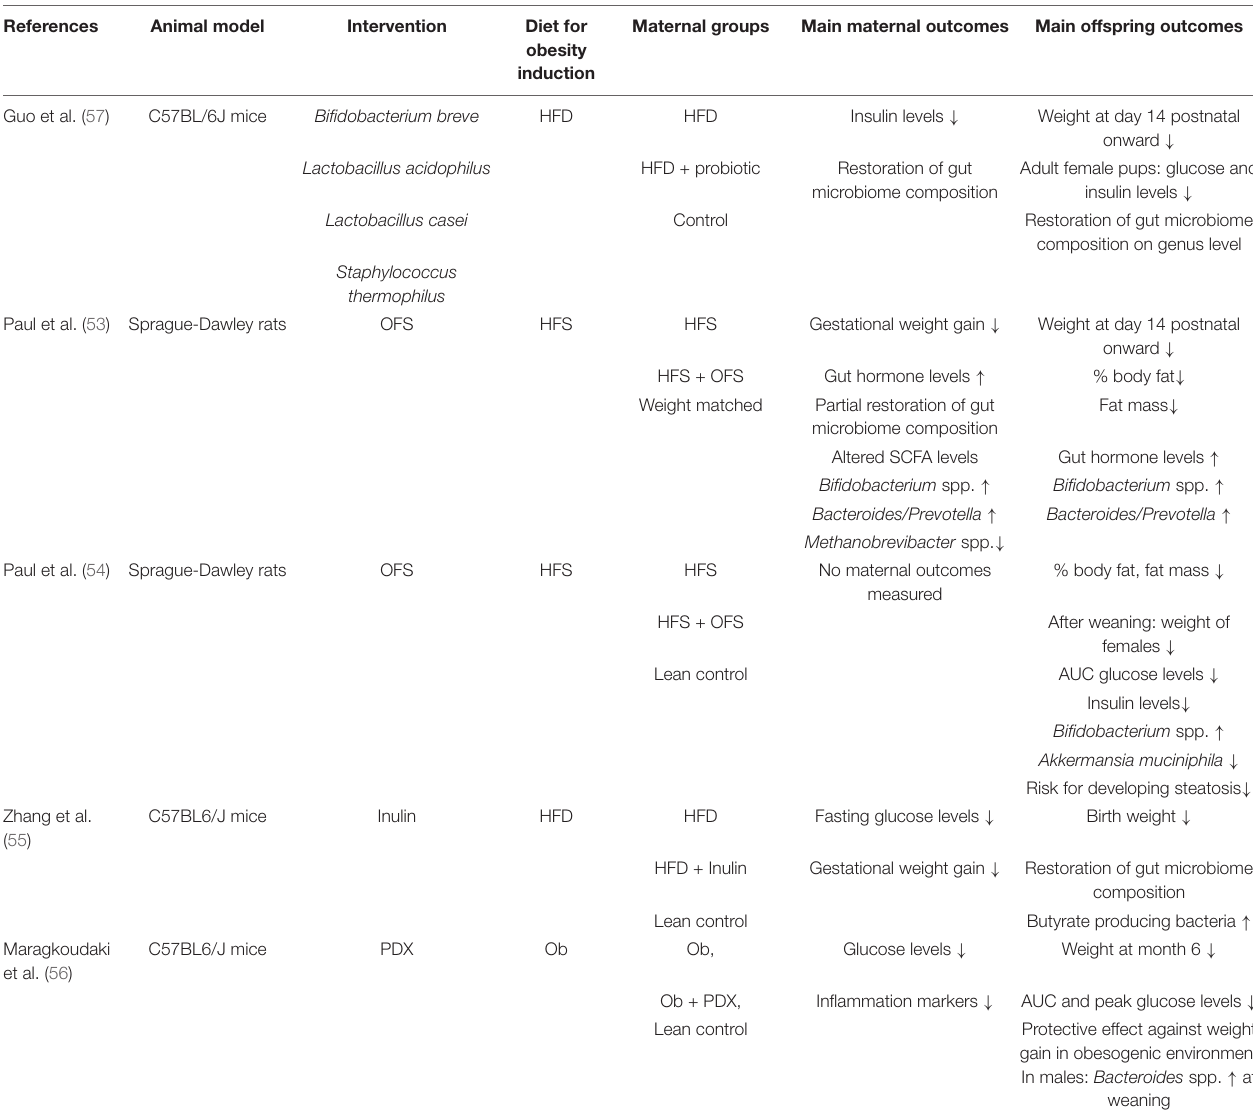
TABLE 1 | Overview of all included animal studies, investigating the effect of prebiotic and probiotic supplementation against the background of maternal obesity a